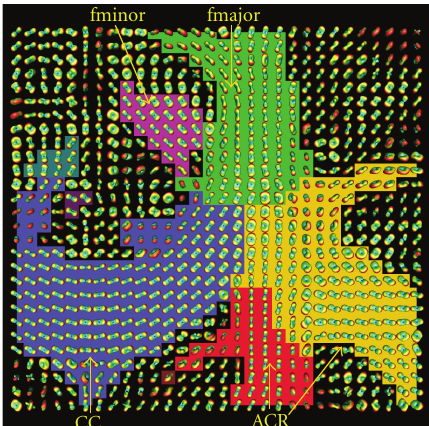
Figure 8: Our proposed algorithm is able to identify important white matter fiber bundles on an axial slice of a real dataset. The cropped axial slice shown in Figure 6(a) has been segmented. In the labeled ODF visualization, each color represents one of the clusters found. The white matter labels are CC: Corpus Callosum, ACR: An- terior Corona Radiata, fmajor: Forceps Major and fminor: Forceps